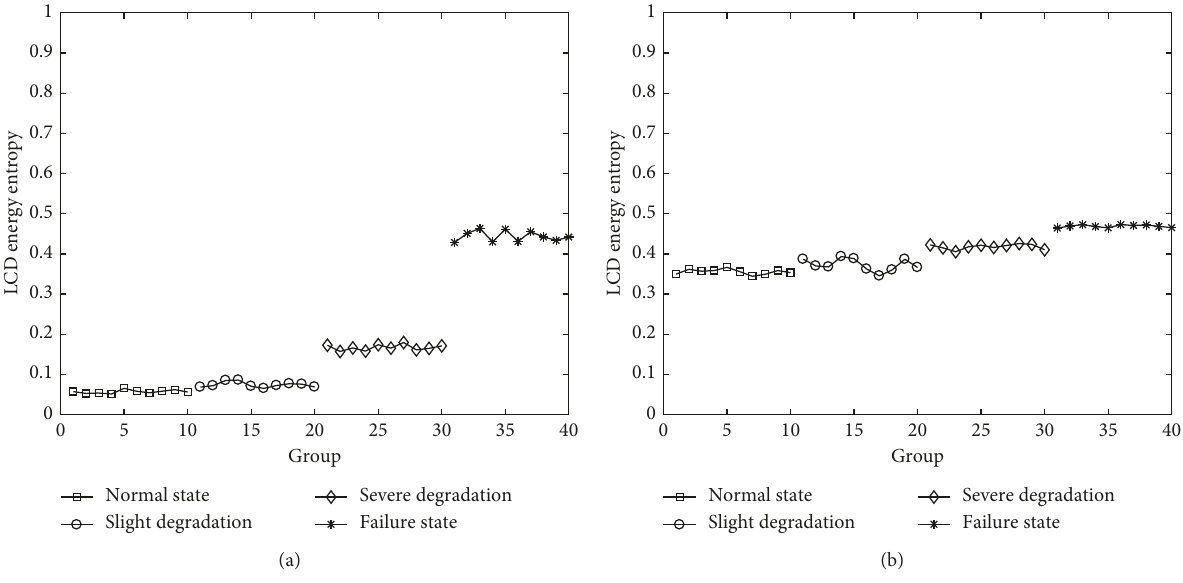
Figure 10: The calculation results of LCD energy entropy: (a) original signal; (b) reconstructed signal.